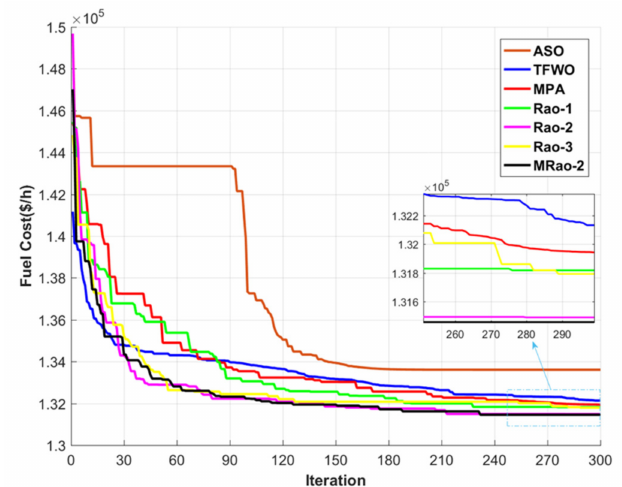
Figure 14. Convergence characteristics of all methods for case 4.